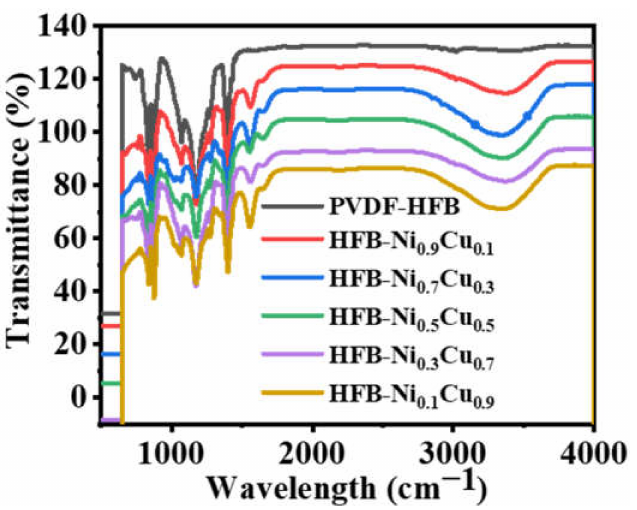
Figure 5. FTIR charts of PVDF-HFP and Ni x Cu 1 − x /PVDF-HFP NF